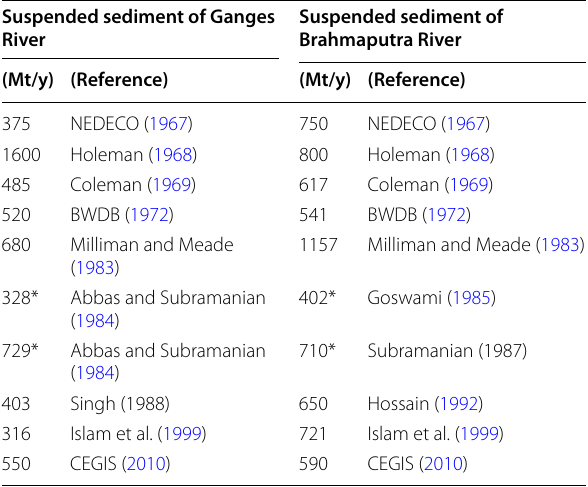
Table 1 Estimates of suspended sediment load (million tons/ year) of the Ganges–Brahmaputra River from different